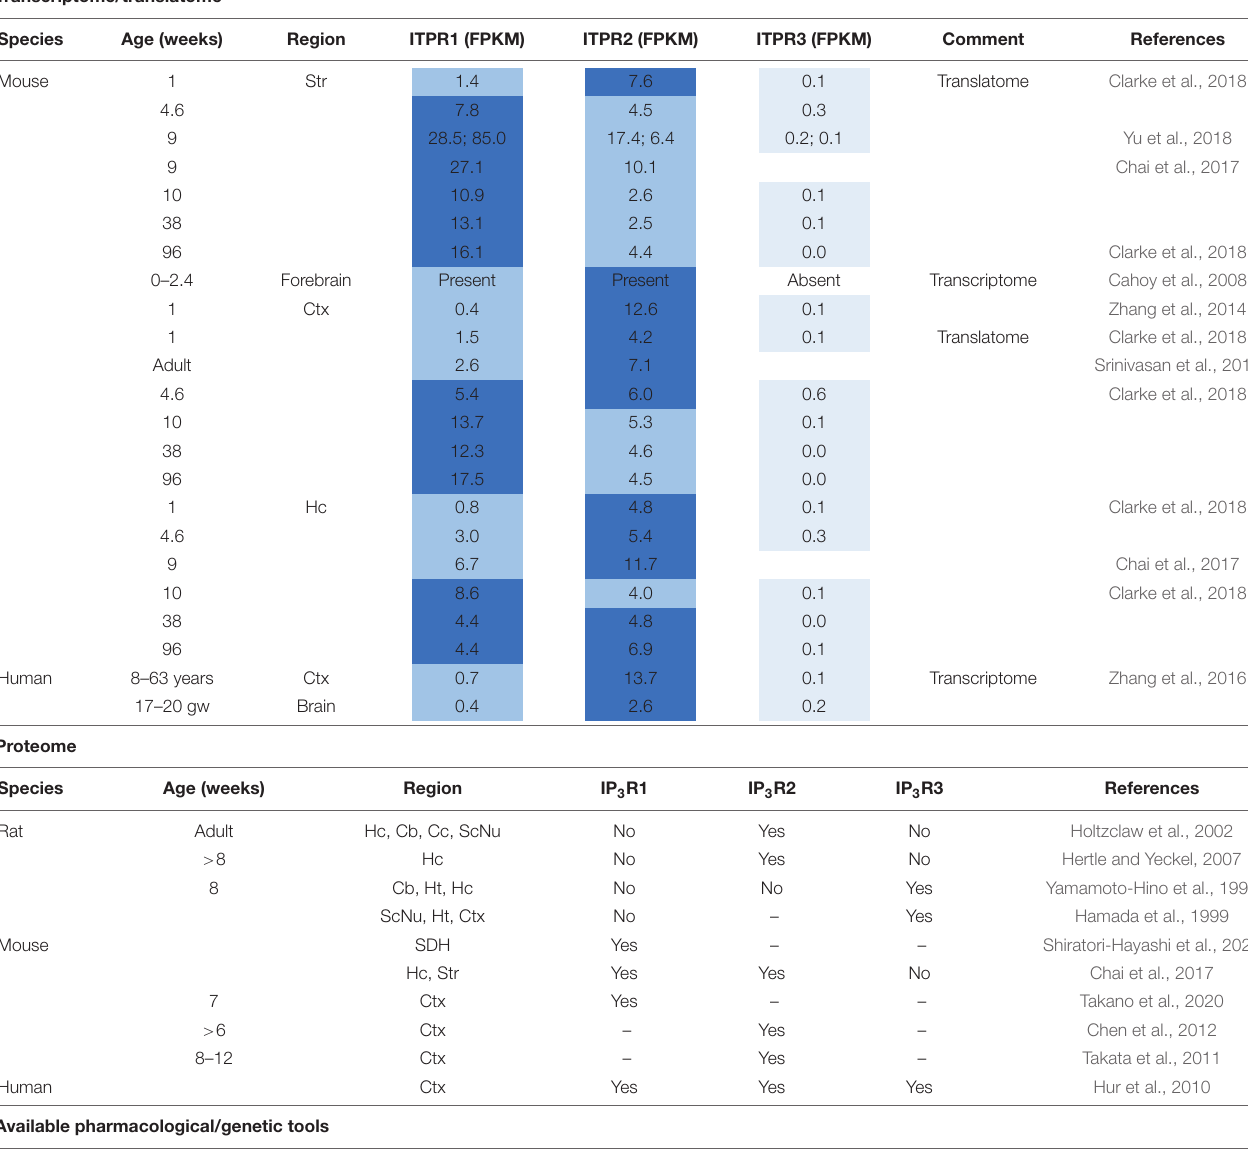
TABLE 1 | Dissecting IP 3 R